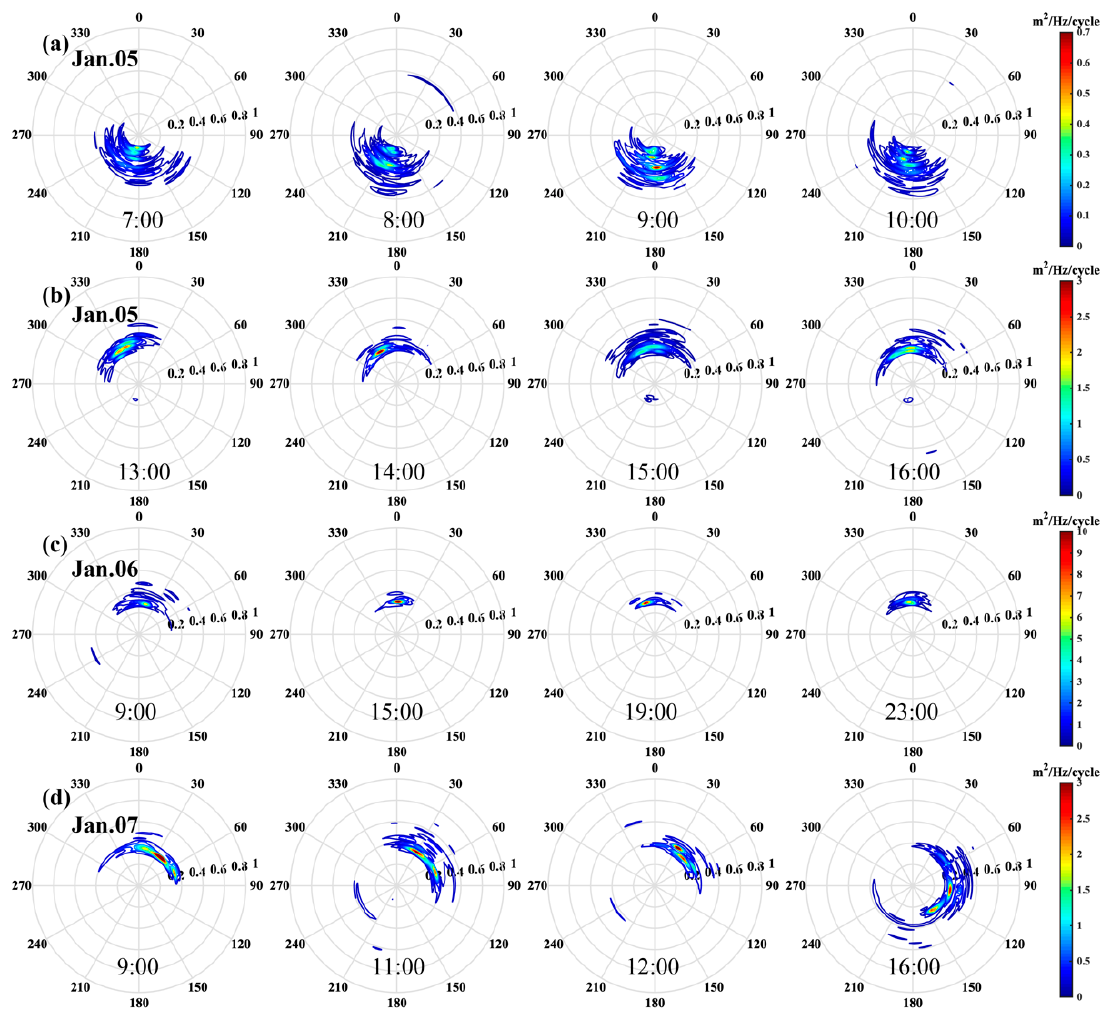
Figure 7. Hourly directional wave spectrum, as observed by the CSI 3 in the Case I. The 2-D directional spectra are shown in polar contours. ( a ) the prefrontal phase, ( b ) frontal passage phase ( c , d ) postfrontal phase from January 5 to 7 .